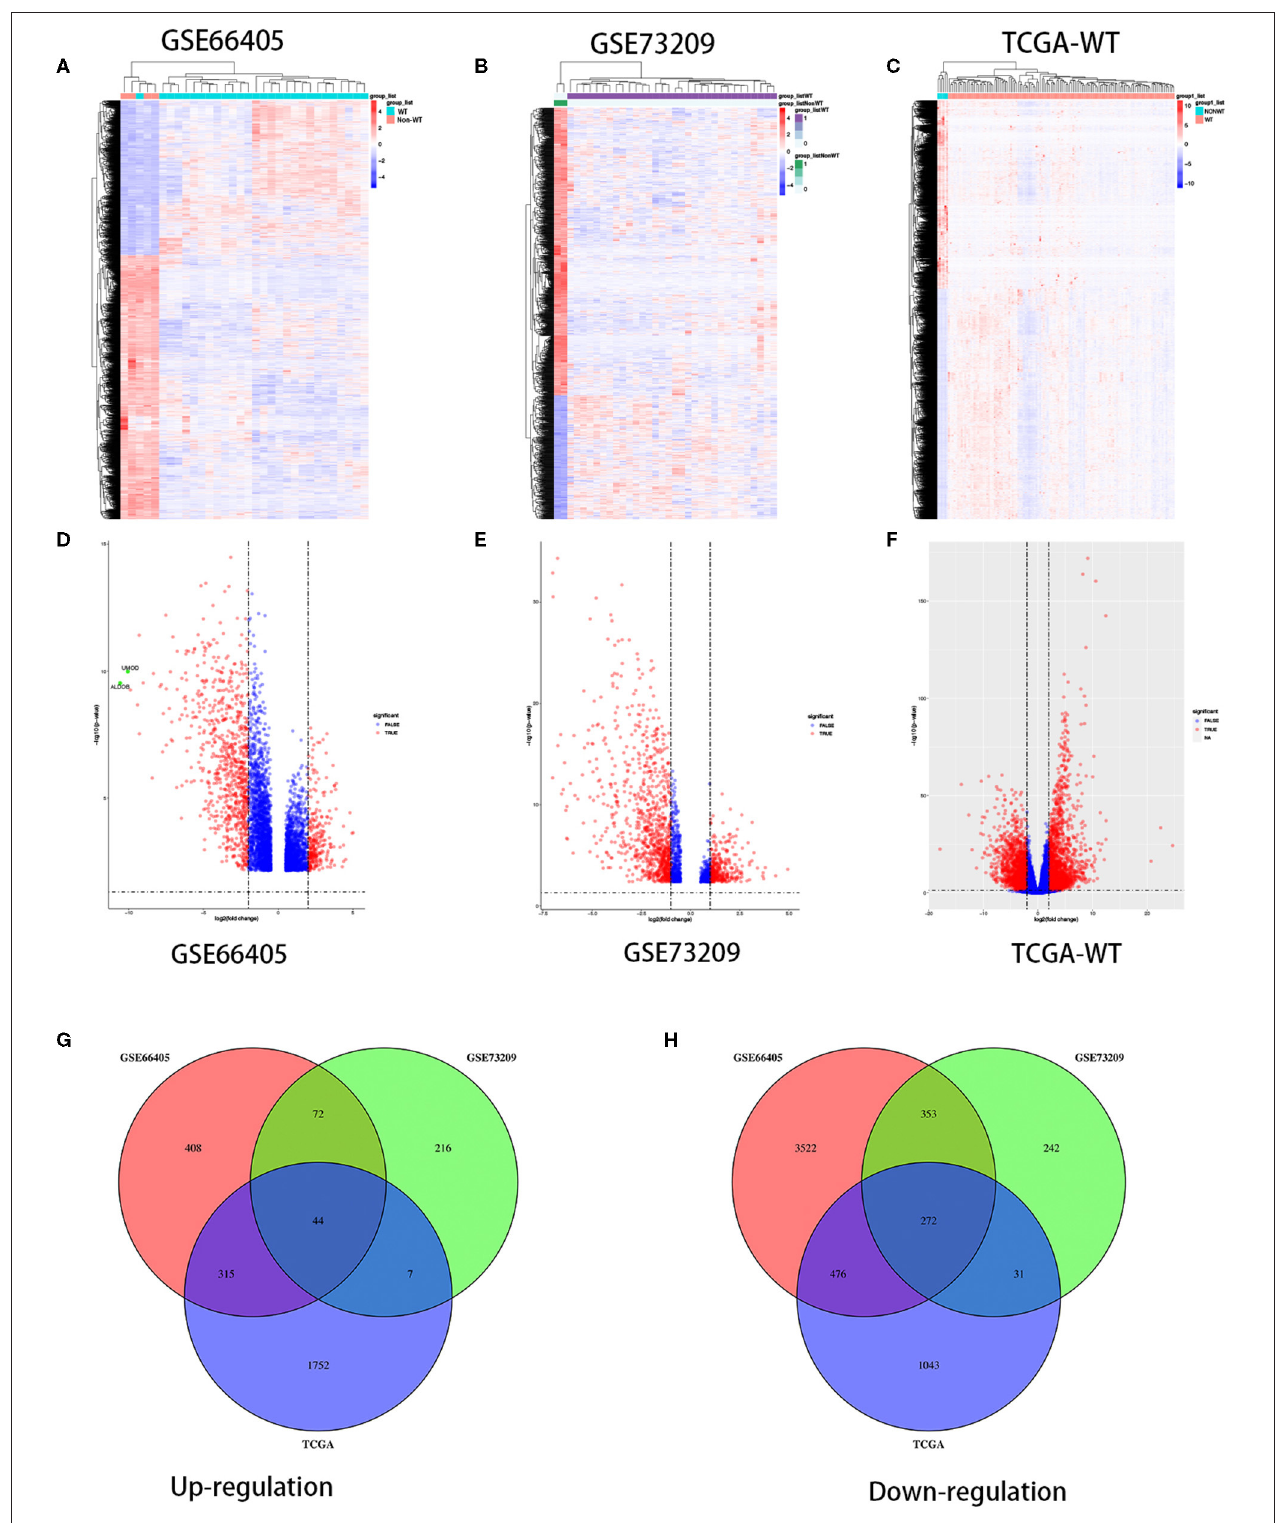
FIGURE 1 | Differentially expressed genes in three independent datasets. Heatmaps of the DEGs in the WT gene expression datasets GSE66405, GSE73209, and TCGA-WT, respectively (A–C) . Volcano plots of genes that are significantly different between WT tissues and normal controls in datasets GSE66405, GSE73209, and TCGA-WT, respectively (D–F) . X axis indicates the fold change (log-scaled), whereas the Y axis shows the p -values (log-scaled). Each symbol represents a different gene, and the red color of the symbols categorizes the upregulated/downregulated genes falling under different criteria ( p value and fold-change threshold). p < 0.05 is considered as statistically significant, whereas fold change = 1.5 is set as the threshold (D–F) . The common differentially expressed genes among GSE66405, GSE73209, and TCGA (G,H) . Frontiers in Pediatrics |